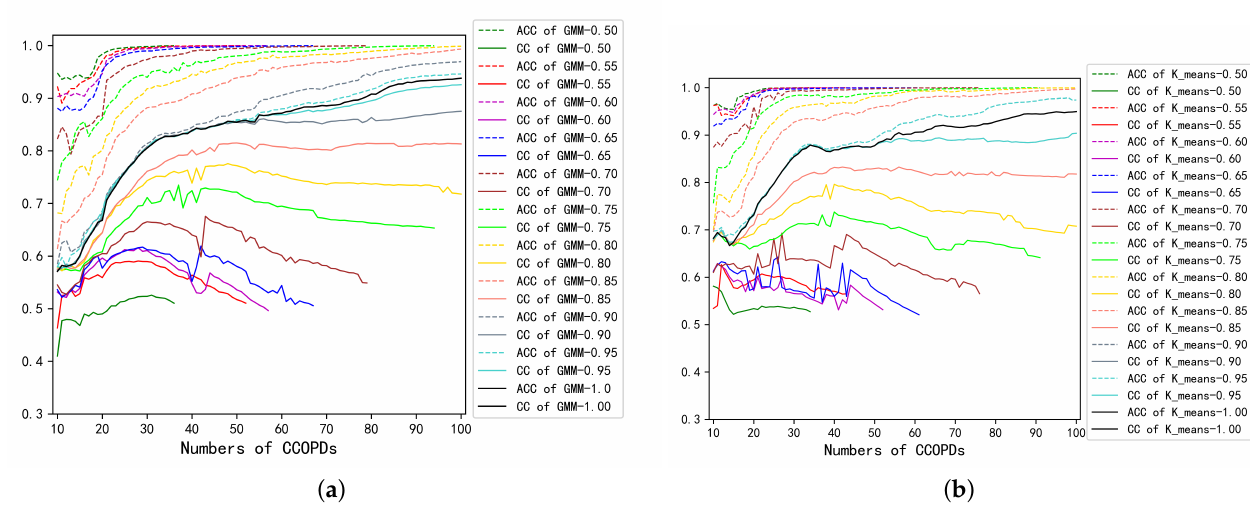
Figure 8. The results of the coverage coefficients (CCs) and the augmented coverage coefficients (ACCs) of GMM-disjunctive models and K-means-disjunctive models with different CTs. ( a ) The CCs and ACCs of the GMM-disjunctive model with different CTs. ( b ) The CCs and ACCs of the K-means-disjunctive model with different